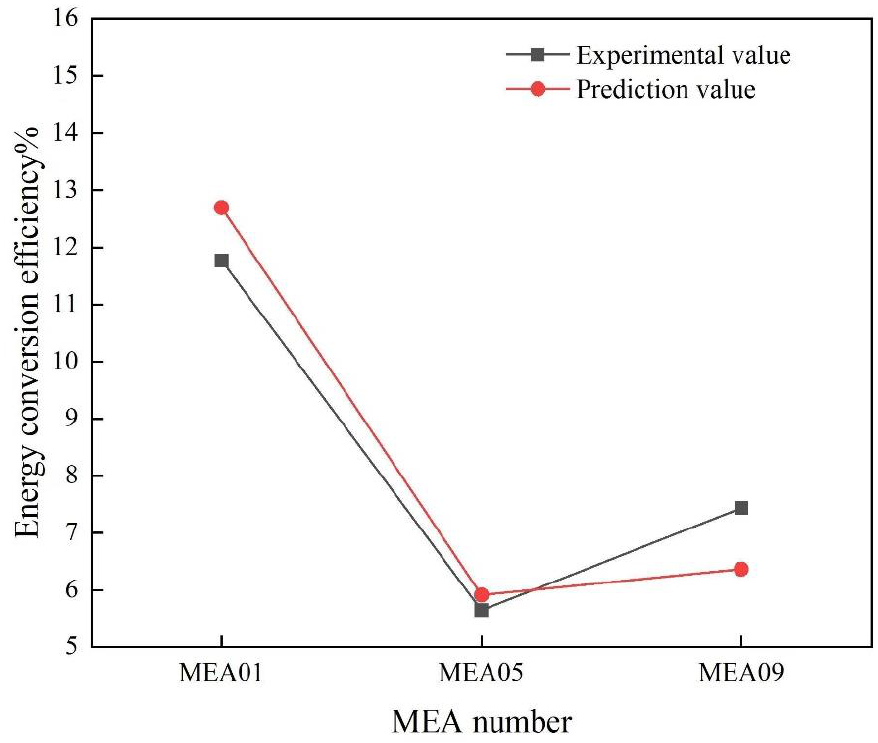
Figure 5. Energy conversion efficiency comparison with operational uncertainty.